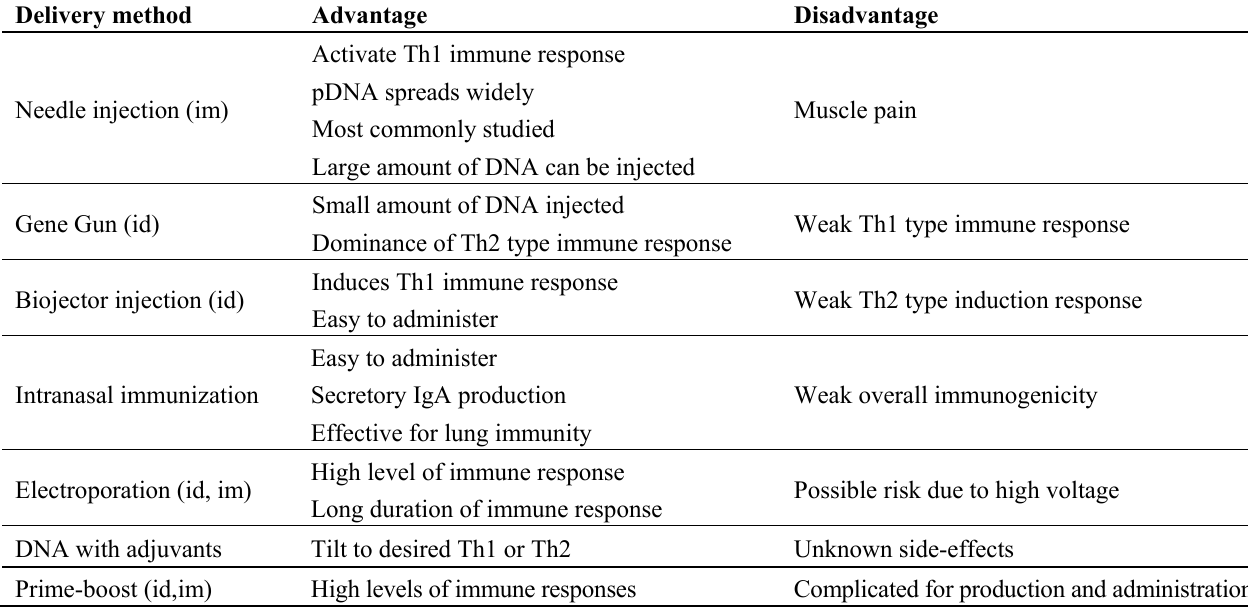
Table 1. Advantages and disadvantages of DNA vaccine administration